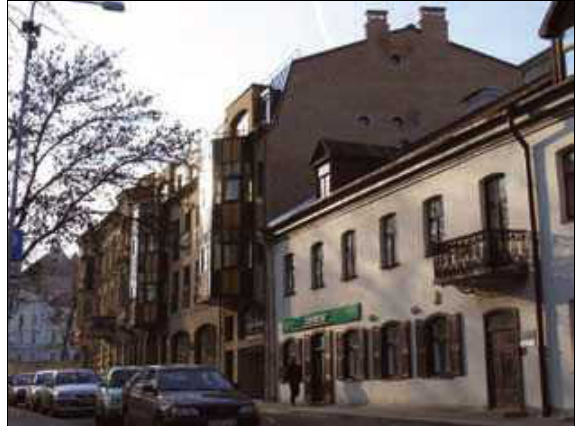
Fig. 1. blocks of flats with the office, commercial and